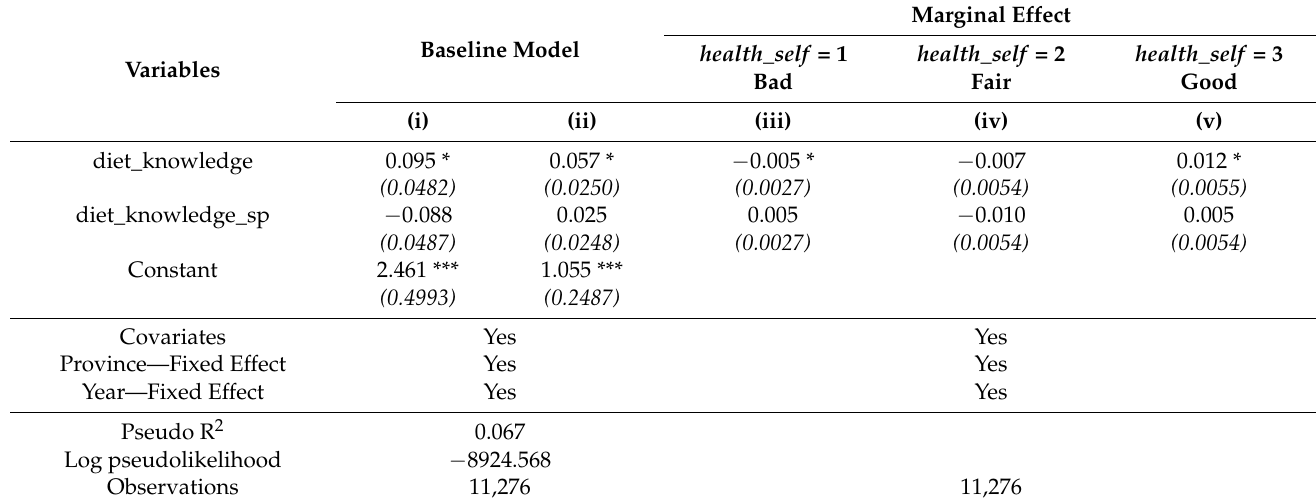
Table 4. Estimation results of the effect of the wife’s dietary knowledge on the husband’s health based on the generalized ordinal logit model.